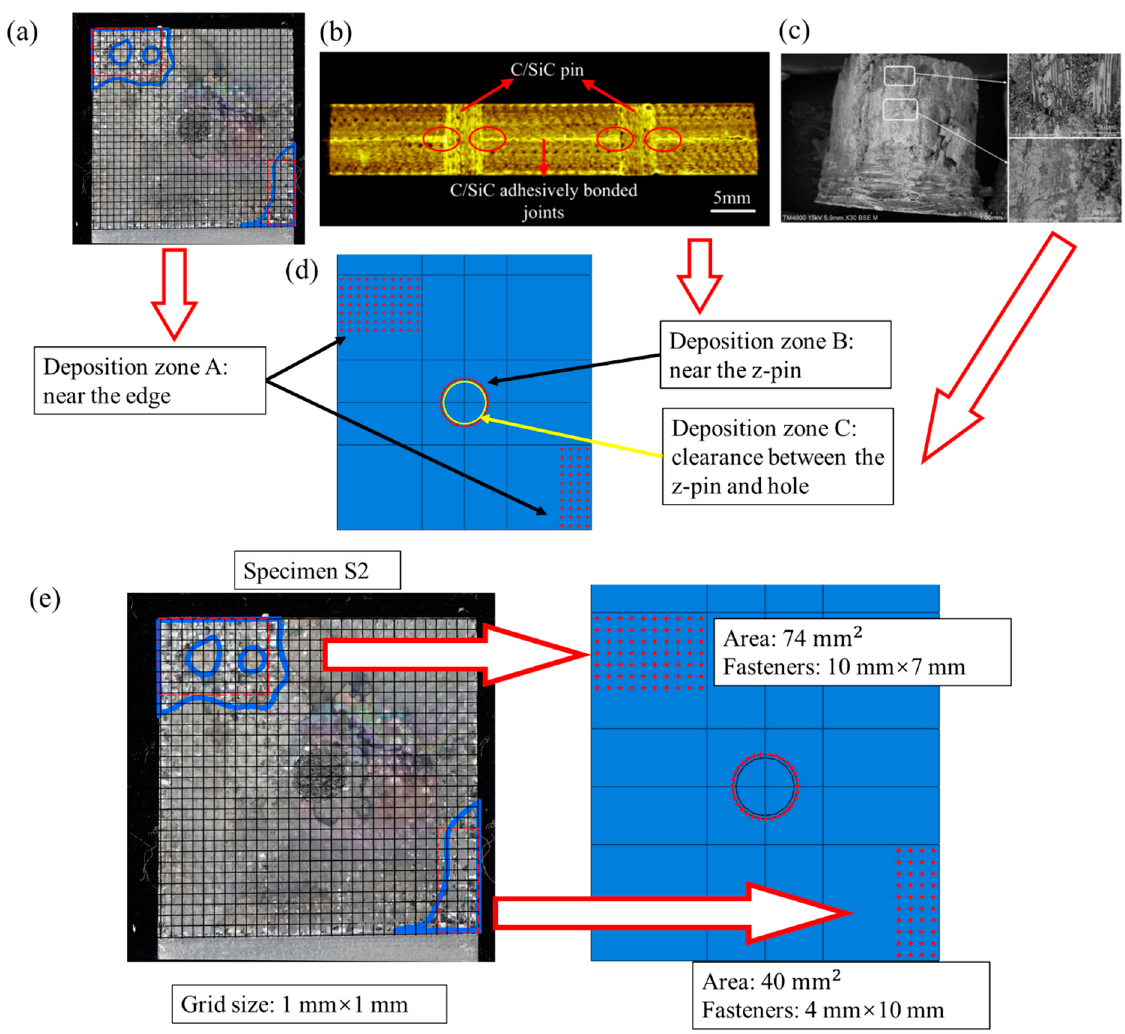
Figure 7. Three types of SiC deposition zones in the C/SiC z-pinned/bonded hybrid single-lap joint: ( a ) deposition zone A: near the edge; ( b ) deposition zone B: near the z-pin [10]; ( c ) deposition zone C: clearance between the z-pin and hole [27]; ( d ) numerical model; ( e ) Fasteners’ distribution with similar area in deposition zone A.